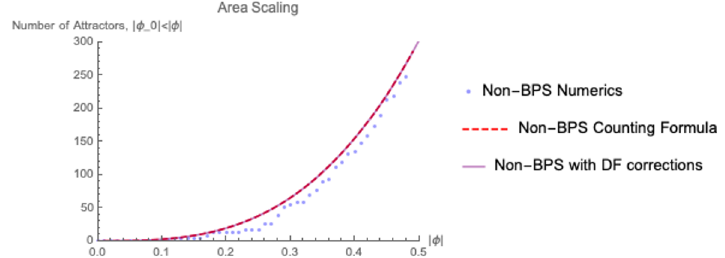
Figure 4 . Comparison of numerics with the analytic predictions (3.32) and (3.33). The latter two predictions are indistinguishable. In order to focus on entropies to which our predictions apply, we only include non-BPS attractors with S min = 225 < S < S max = 275, where S min and S max are estimated from (cid:12)gure 2; correspondingly, our theoretical plot is of N ( S max ; R ) (cid:0)N ( S min ; R ), where R = f (cid:30) 0 : j (cid:30) 0 j < j (cid:30) jg . We suspect that inclusion of attractors at the edges of the range [ S min ; S max ] is responsible for the evident small systematic errors. As evidence for this, we constructed analogous plots with di(cid:11)erent choices of S min and S max and observed that the agreement between the numerics and analytic predictions worsened as we increased the size of the interval [ S min ; S max ].